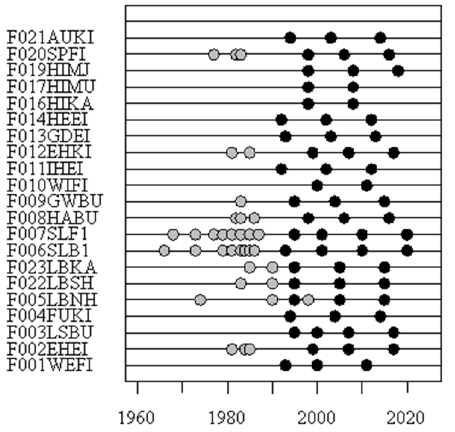
Figure 3. Sampling years of soil inventories at the permanent soil monitoring plots in Lower Saxony, Germany. (Black cycles: sampling design complies with the ICP Forests specifications; grey cycles: inventories with partly deviating sampling design, but comparable analytical methods).